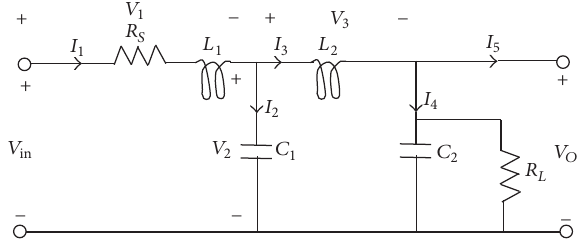
Figure 3: Fourth-order Butterworth low pass LC ladder.